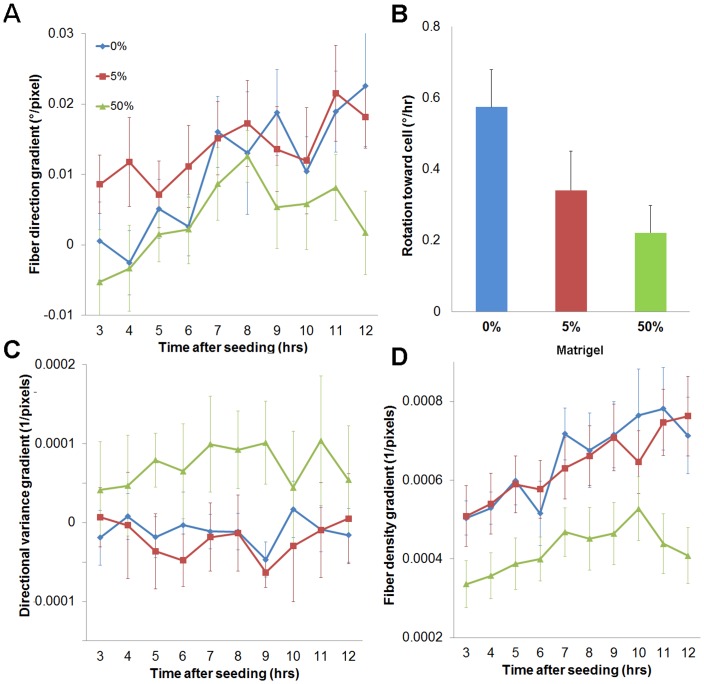
Early changes in collagen spatial organization.(A) The fiber direction gradient increases from the initial time point, suggesting fibers closer to the cell structure become increasingly oriented perpendicular to the cell surface over time. Significant differences relative to the initial time point were only detected in 0% Matrigel at 9, 11, and 12 hrs (p = 0.0001). (B) The rate of fiber rotation over the first 12 hours of culture in regions 40 μm from the cell surface was significantly faster in 0% Matrigel compared to 50%. (C) No significant changes in the directional variance gradient were observed over the first 12 hours indicating a lack of local anisotropy developing within the fiber network at the initial stages following seeding. (D) The spatial gradient of fiber density significantly increased over time in all groups, indicating some level of cell-mediated gel compaction regardless of Matrigel composition. Data are represented as mean +/− SD.